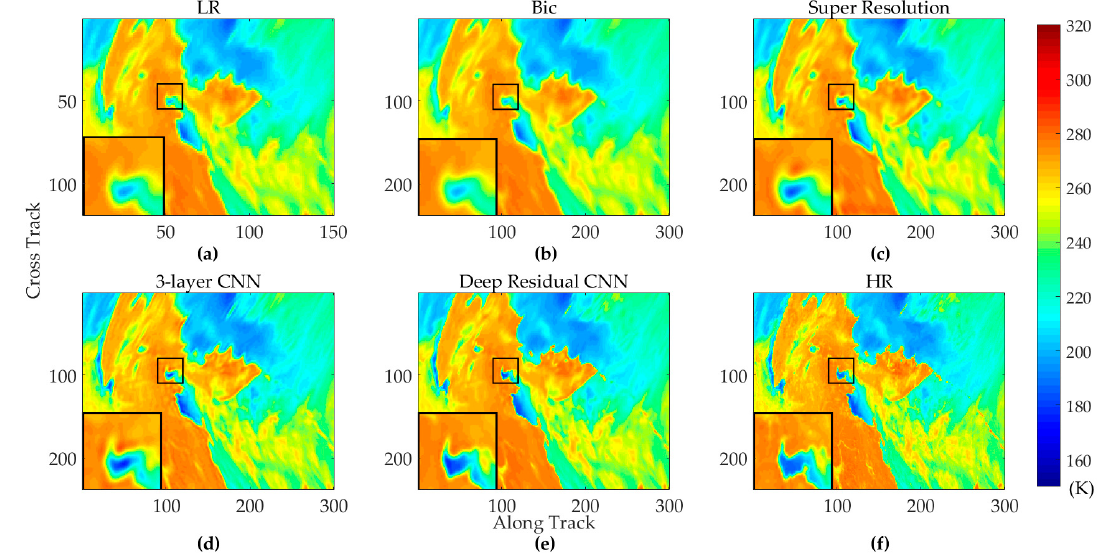
Figure 7. Experiment results of the scene 2 (in training set). ( a ) The simulated antenna temperature image I LR ; ( b ) The bicubic interpolation result; ( c ) The super resolution result; ( d ) The 3-layer CNN result; ( e ) The deep residual CNN result; ( f ) The simulated brightness temperature image I HR .